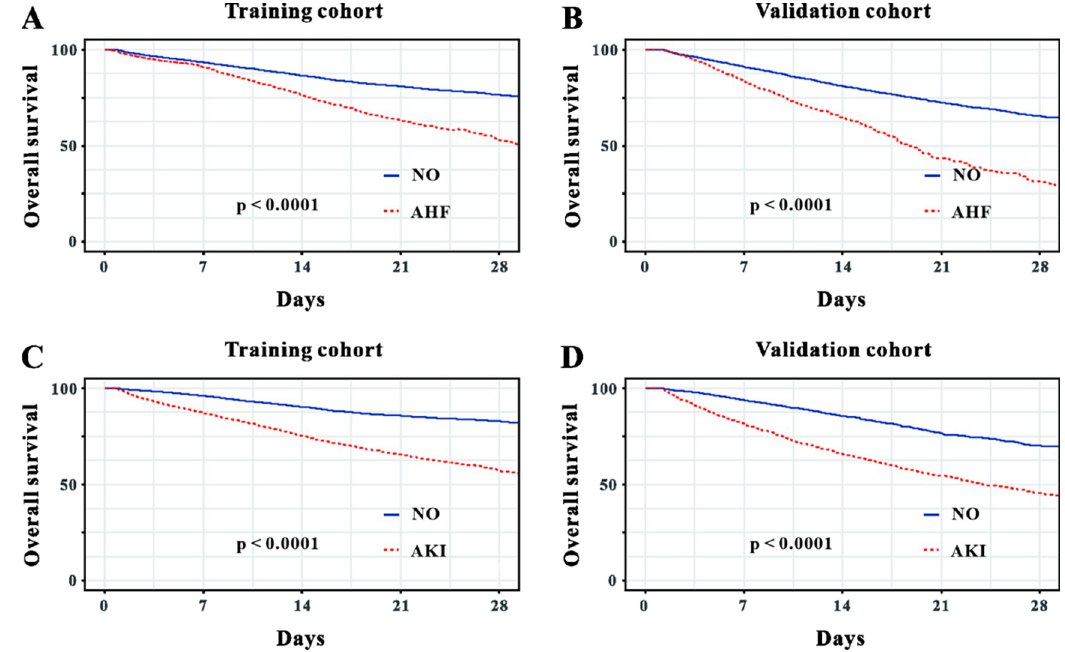
Fig 2. The Kaplan-Meier curves of overall survival for all patients stratified by acute heart failure ( A and B ) or acute kidney injury ( C and D ) in the training cohort and in the validation cohort.